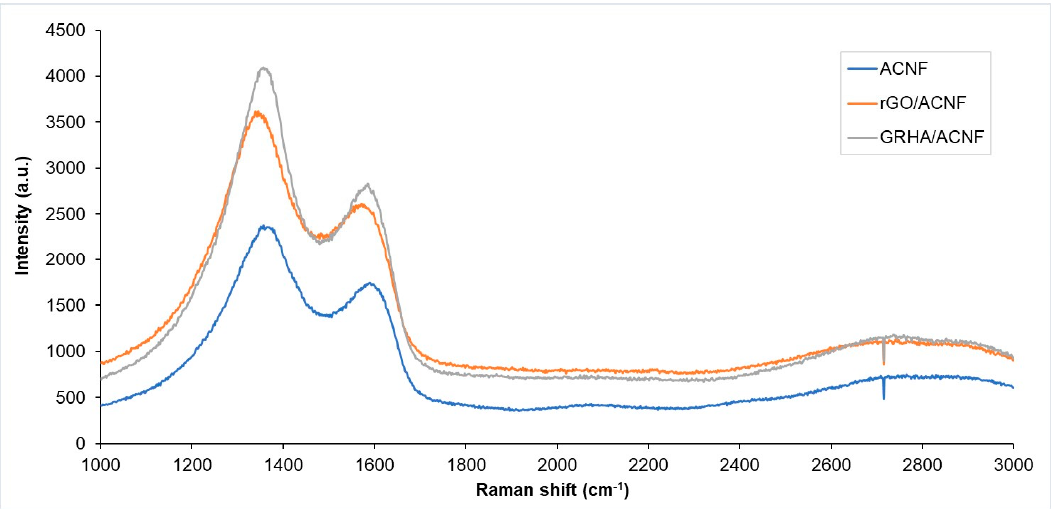
Figure 2. Raman spectra of the samples. ACNF: activated carbon nanofibers, rGO: ACNF: activated carbon nanofibers, GRHA: graphene-derived rice husk ashes.